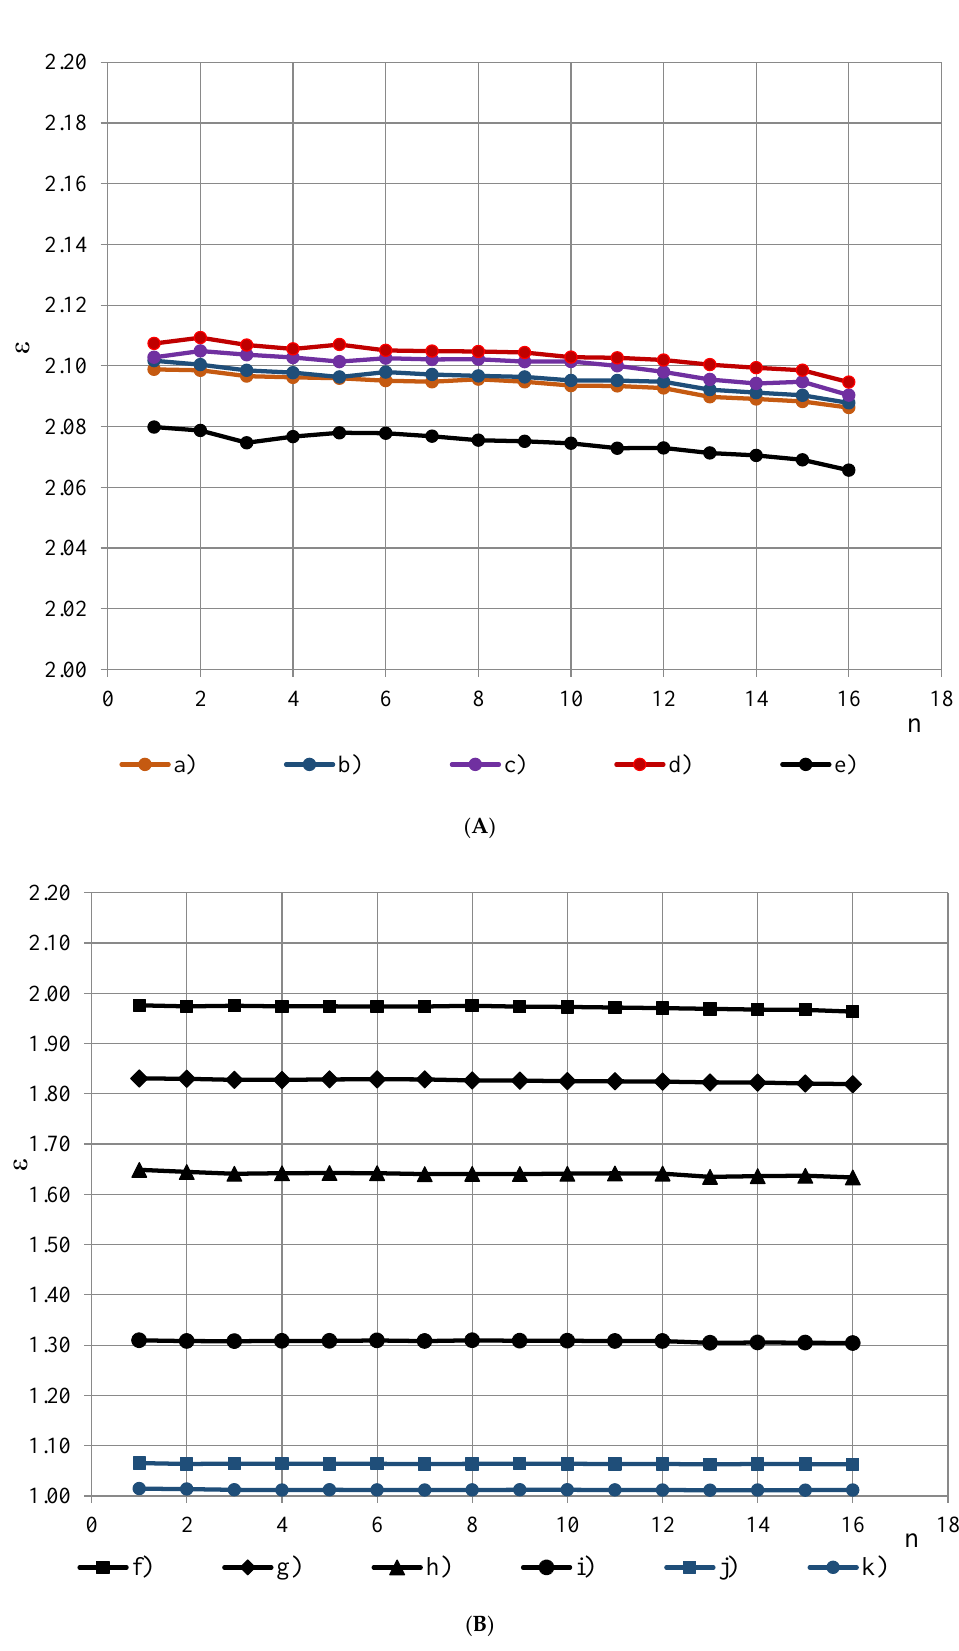
Figure 4. ( A ) Permittivity spectra of PTFE samples of thickness (a) 24.64, (b) 20.10, (c) 16.18, (d) 10.99 and (e) 5.94 mm. ( B ) Permittivity spectra of PTFE samples of thickness (f) 4.10, (g) 2.90, (h) 1.77 mm, (i) 0.77 and PTFE films of thickness (j) 0.20 mm and (k) 0.04 mm.